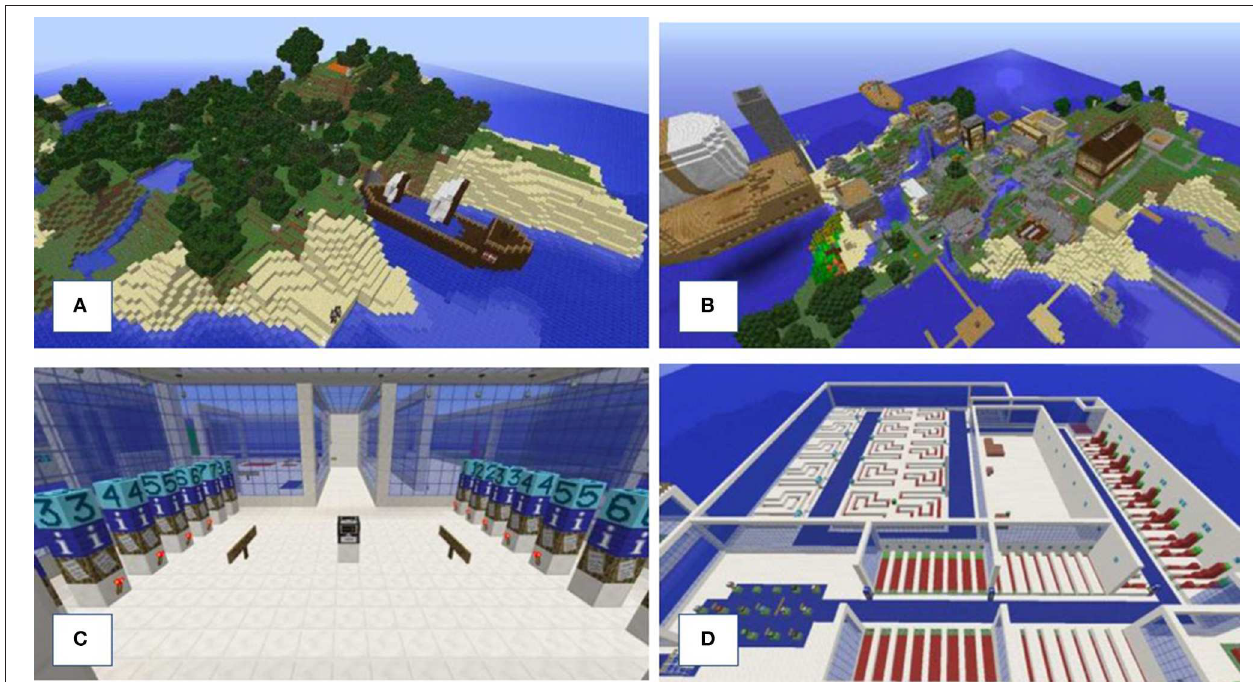
FIGURE 1 | (A) Island at the start of the game when students’ ship has wrecked. (B) Island after students have created their society (game activity between club meetings, Captain’s quests). (C) Hall of quests, which was the place for information sharing, reflection, and teleportation to the science center. (D) Science center (main quests were played here) with a view into the coding